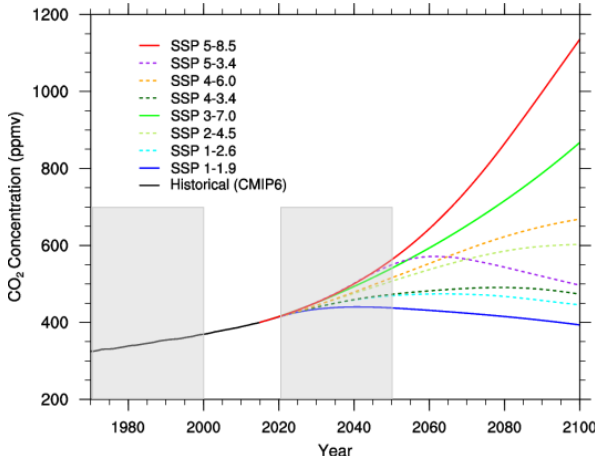
Figure 3. Global CO 2 concentration evolution (ppmv) over the pe- riod 1970–2100 according to eight different SSPs. The three scenar- ios chosen for this study (SSP 1-1.9, SSP 3-7.0 and SSP 5-8.5) are highlighted by solid lines. Shaded bars highlight the past and future simulations